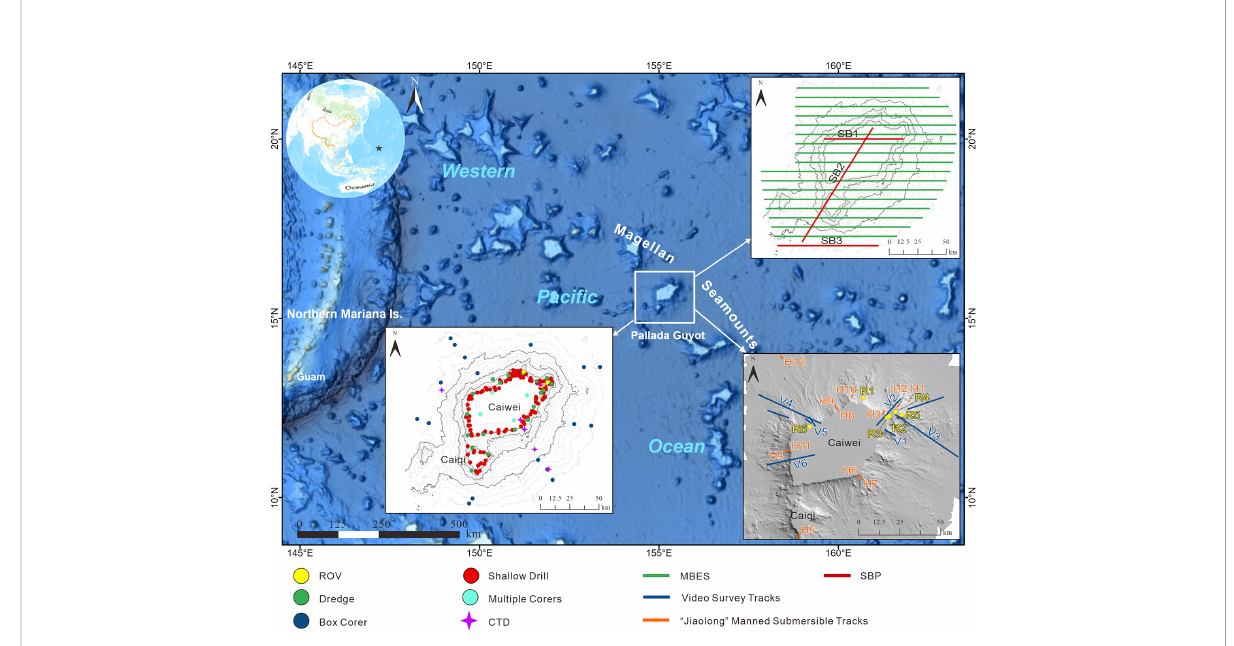
FIGURE 1 Overview map (source: GEBCO_2021) and survey data of the Pallada